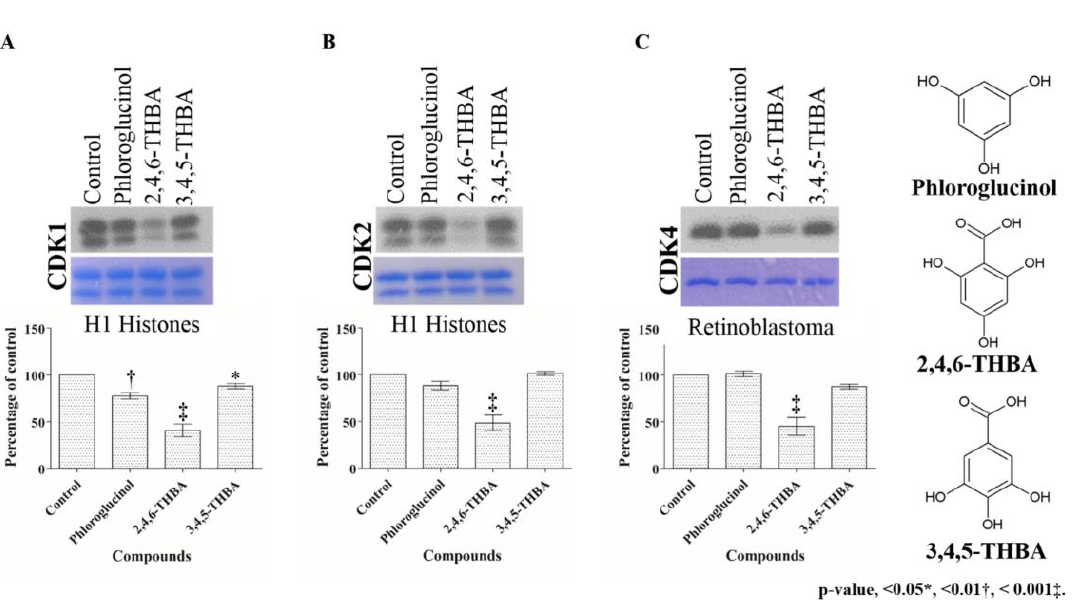
Figure 3. Comparison of the effect of phloroglucinol, 2,4,6-THBA and 3,4,5-THBA on CDK1 ( A ), CDK2 ( B ) and CDK4 ( C ) activity. Upper panel shows phosphorylation pattern of H1 histones (CDK1 and CDK2) and retinoblastoma protein (CDK4), in the presence of different compounds. The middle panel shows Coomassie Blue stained proteins. The lower panel shows quantification of the blots in the upper panel.